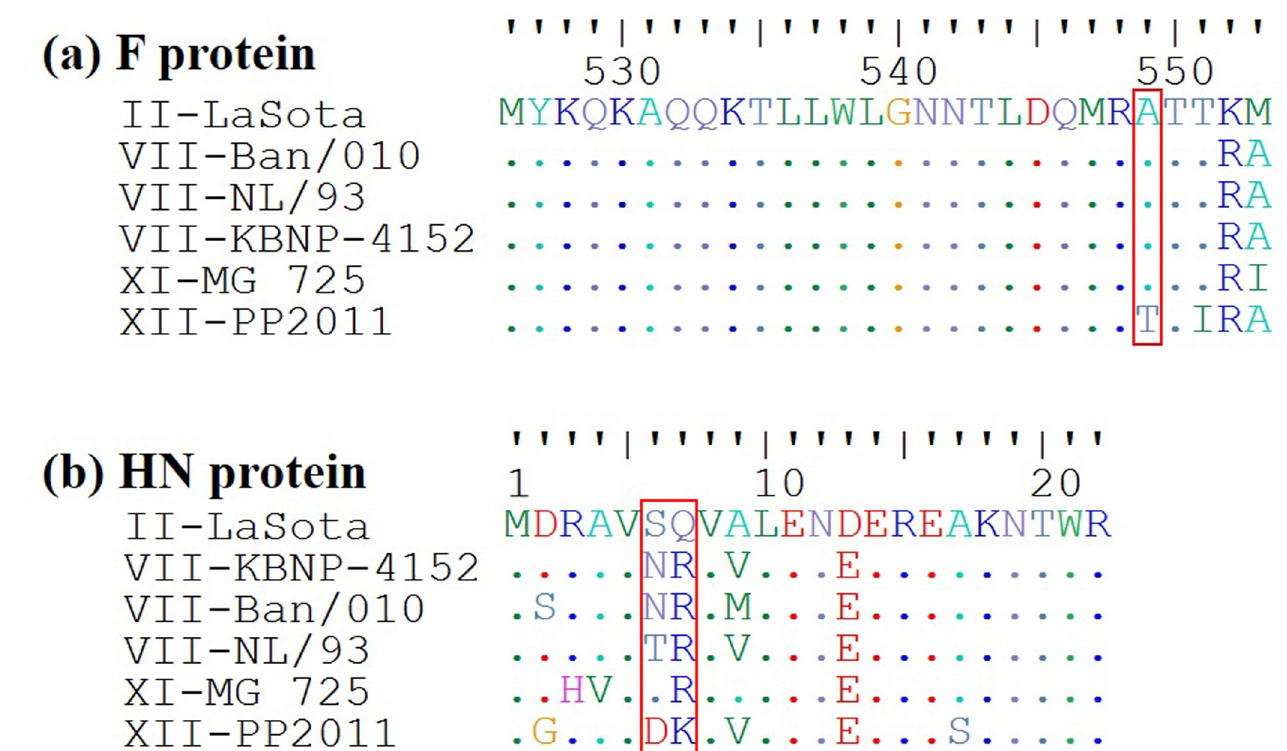
Fig 5. Amino-acid sequence alignment of F (a) and HN (b) cytoplasmic tails from NDVs used to generate chimeric viruses. F and HN sequences from strains Ban/010 (Acc. N˚ HQ697254) [22], NL/93 (Acc. Nhttp JN986837) [23], KBNP-4152 (Acc. N˚ DQ839397) [21] and MG_725 (Acc. N˚ HQ266602) [24] were previously used to generate chimeric NDVs in LaSota (Acc. N˚ AF077761) backbone. PP2011 (Acc. N˚ KR732614) [14] F and HN cytoplasmic tail sequences were used in this study to generate rLS1-XII-1 strain in the rLS1 backbone. Amino-acid sequences of F and HN cytoplasmic tails are exactly the same for LaSota and